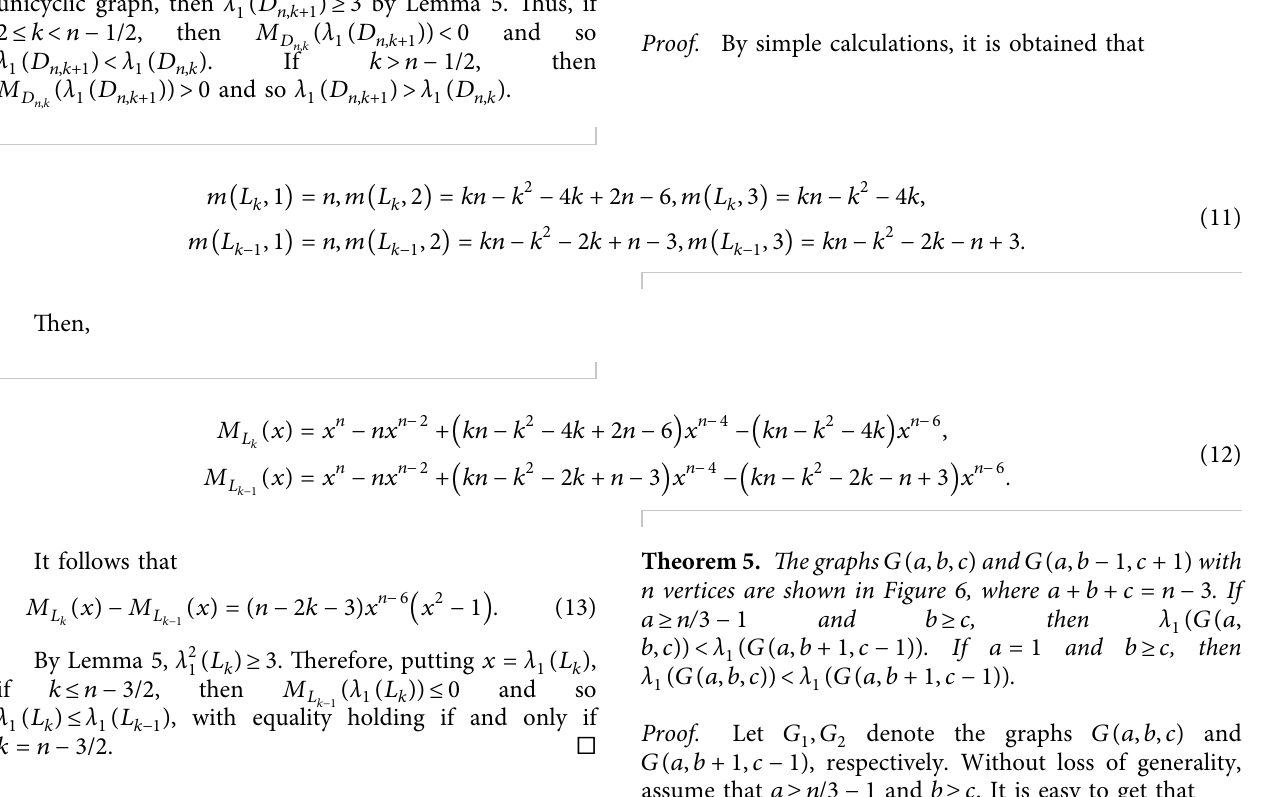
( L ) ≤ λ ( L ) , k k − 1 1 1